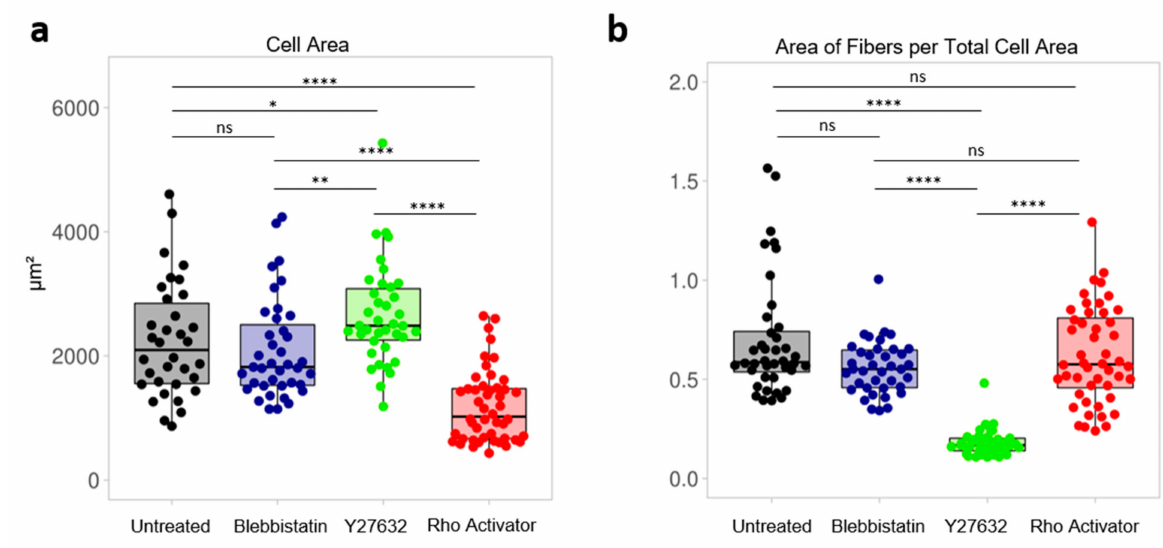
Figure 7. Focal plane analysis. Each dot represents the median of a single cell. ( a ) Cell area of untreated and blebbistatin-, Y27632-, Rho activator-treated cells. ( b ) Area of actin fibers per total cell area of untreated cells and cells treated with blebbistatin, Y27632 and Rho activator. Test: Kruskal- Wallis and post hoc Dunn’s test. ns: p > 0.05, *: p ≤ 0.05, **: p ≤ 0.01, ****: p ≤